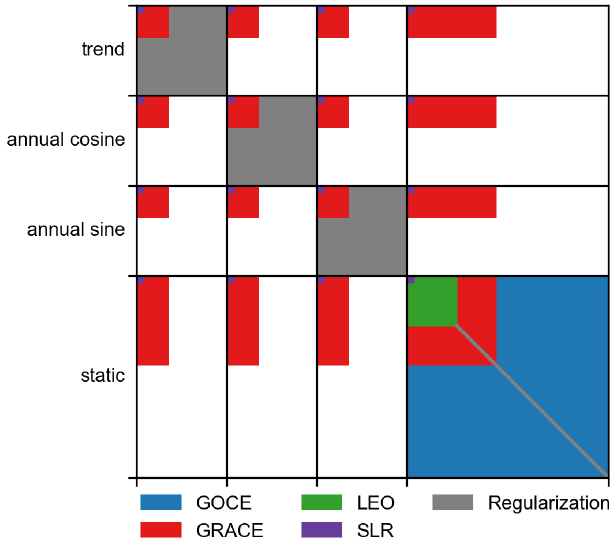
Figure 1. Structure of the combined normal equation coefficient matrix, with all contributions overlaid. The different parameter groups for trend, annual and static potential coefficients are high- lighted and plotted to